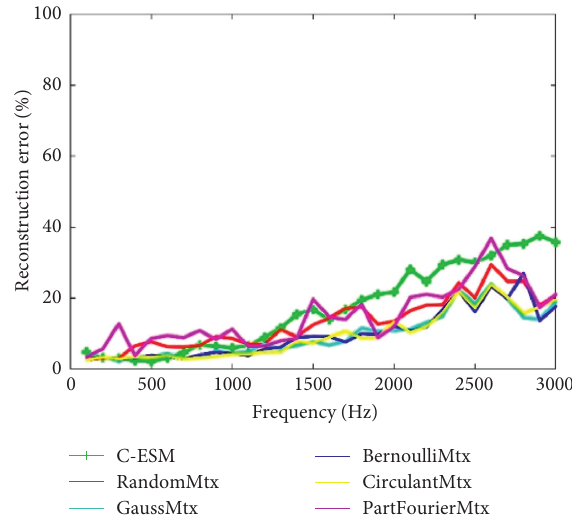
Figure 5: Acoustic pressure reconstruction error with frequency for various methods at 81 sampling points.